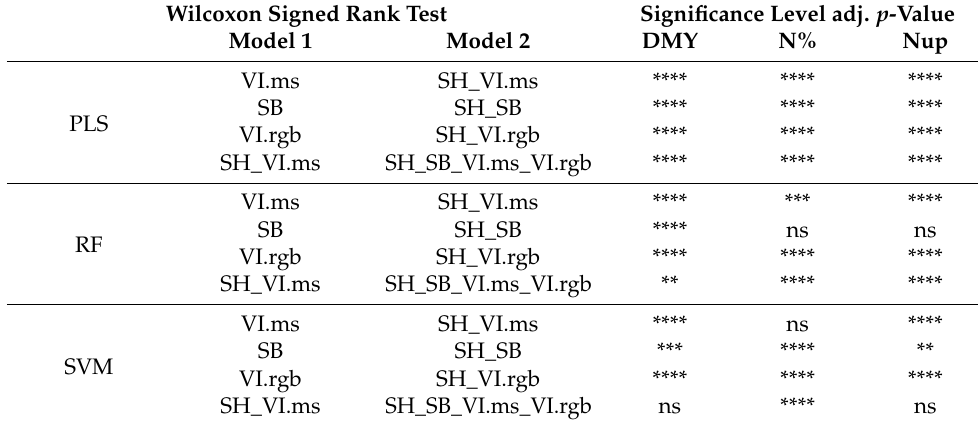
Table A5. Results Wilcoxon signed-rank test.